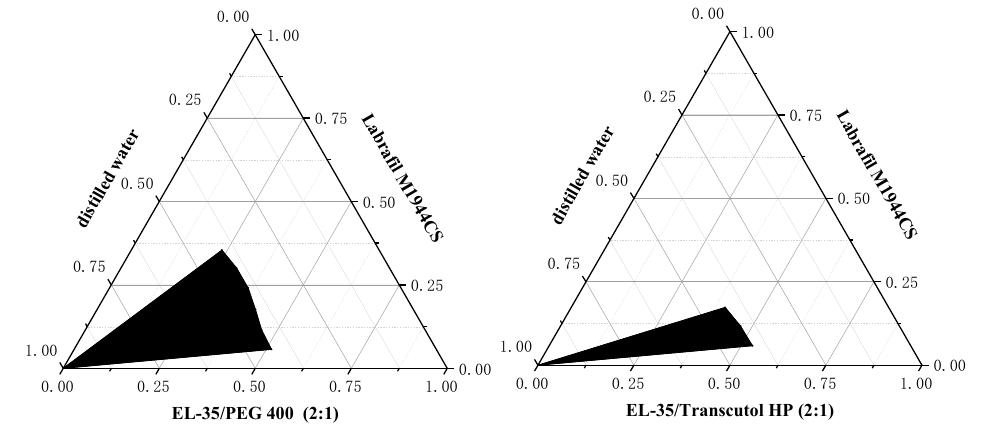
Figure 1. Pseudo-ternary phase diagram of different co-surfactants. The black area represents the microemulsion region, and the white area represents the coarse emulsion region.